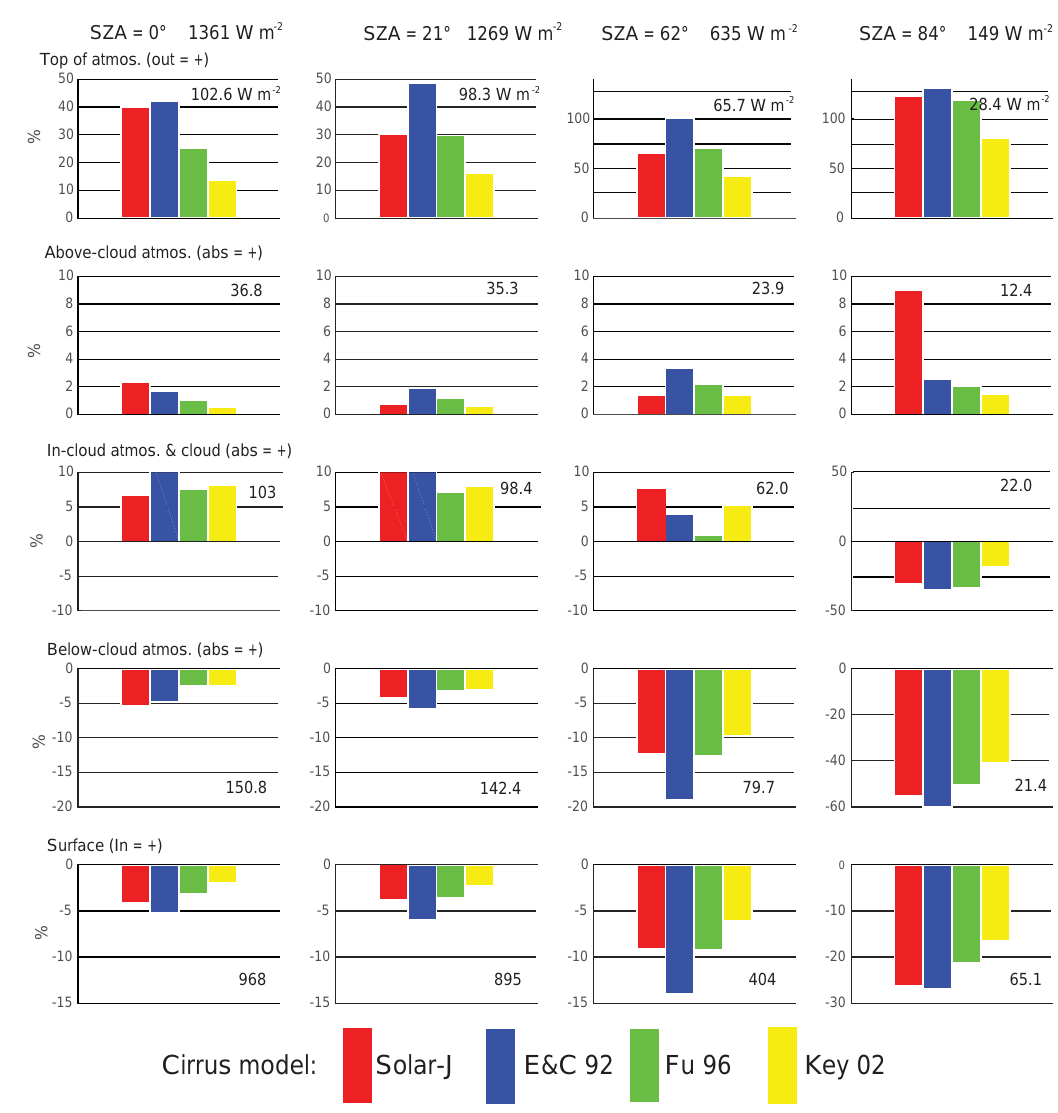
Figure 6. Percent changes (%) in shortwave radiation energy budget relative to the aerosol-free clear sky (surface albedo of 0.06) caused by a cirrus cloud using four different models: Solar-J and the three RRTMG-SW parameterizations for ice clouds. Results are shown for four different solar zenith angles. Changes in the vertical column are divided into five regions: top of atmosphere, atmospheres above, within, and below the cirrus cloud, and at the surface. Single numbers in bold shown in the corner of each panel are the clear-sky energy budget in Wm − 2 averaged over Solar-J and RRTMG-SW for each region. Note that different y -axis scales have been used for large